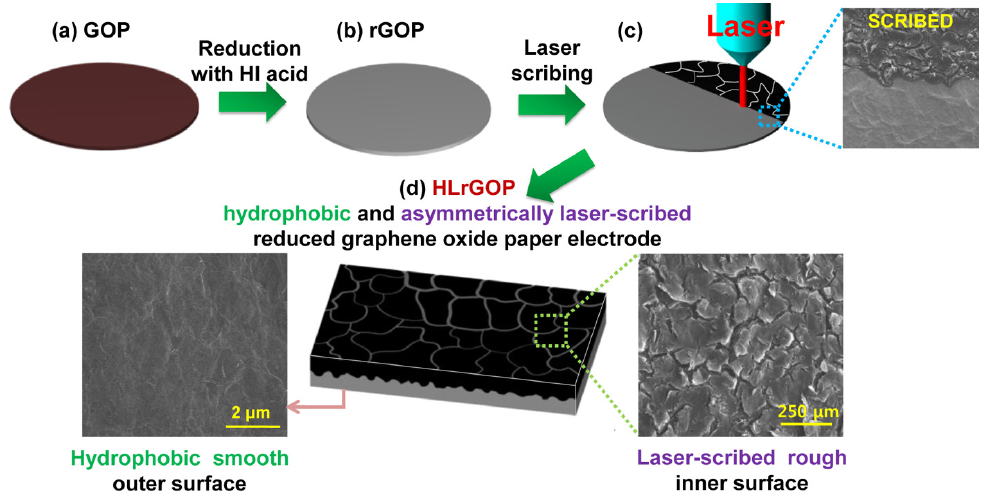
Figure 13. Synthesis of the LrGO paper electrode with hydrophobic and asymmetric laser-cleaned surfaces: ( a ) GO paper (GOP); ( b ) GO paper, reduced with HI (rGOP); ( c , d ) laser-cleaned RGO paper (LrGOP). Reproduced from [37] with permission from American Chemical Society. Copyright 2014.